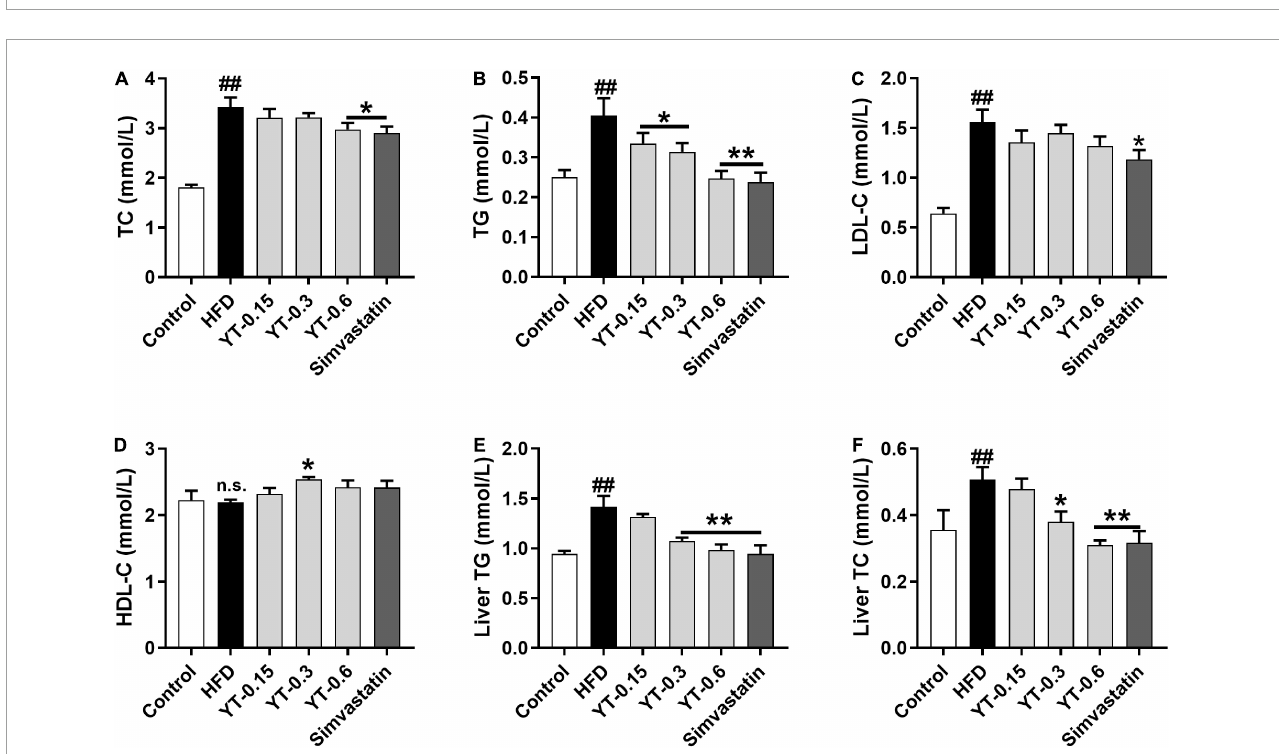
FIGURE2 Effect of YT extract on serum and liver biochemical indices. (A) TG, (B) TC, (C) LDL-C, (D) HDL-C, (E) liver TG, (F) liver TC. Data are presented as mean ± SEM ( n = 6). # p < 0.05 and ## p < 0.01 vs. the control group; * p < 0.05 and ** p < 0.01 vs. the HFD group; n.s. indicates no significant difference between the control and HFD